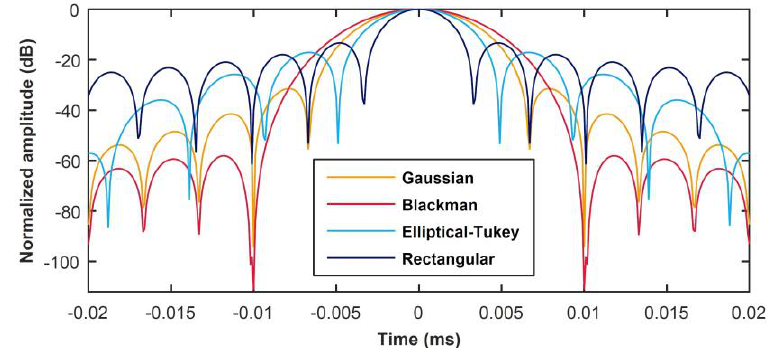
Figure 4. Comparison of the effect of different windowing functions 𝑤(𝑡) applied over the matched filter 𝜓(𝑡) to the PuC output.